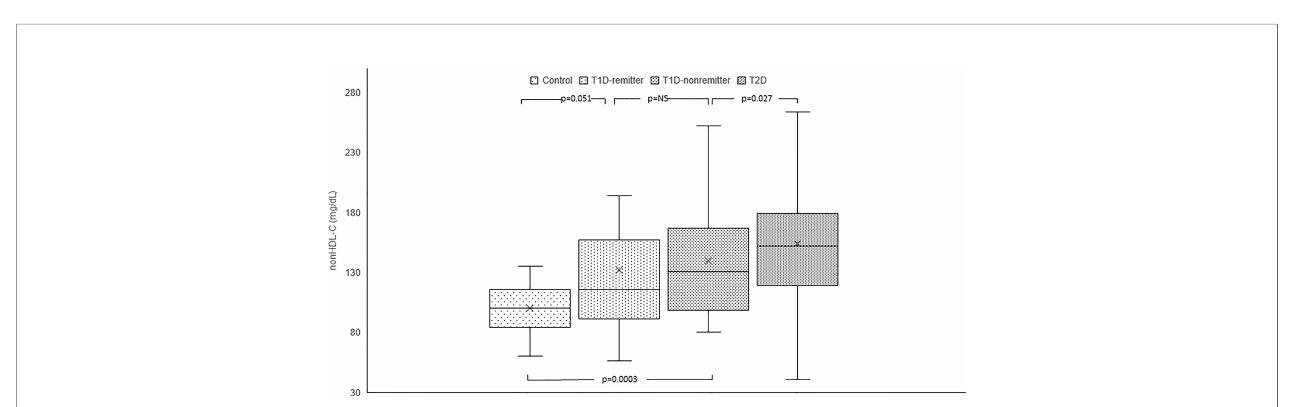
FIGURE 5 | A comparison of the patterns of glycemic control in the remitters, non-remitters, and subjects with type 2 diabetes (T2D) in the fi rst 12 months following the diagnosis of diabetes mellitus [original data from Nwosu et al. (5)].